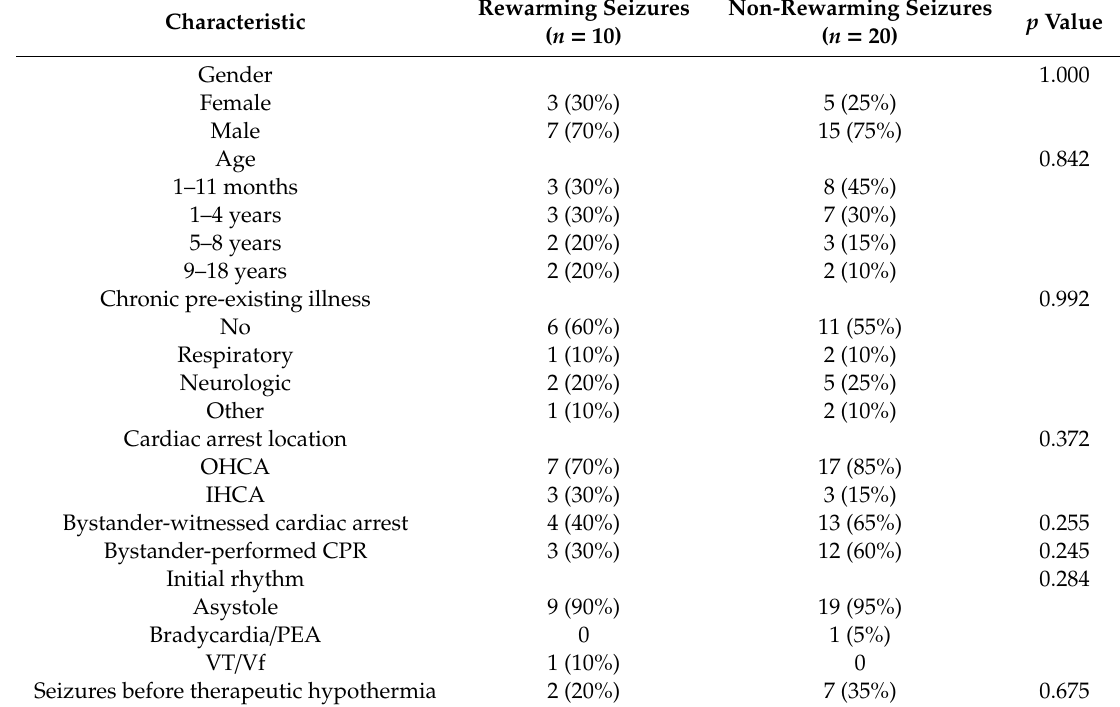
Table 1. The characteristics of 30 children undergoing therapeutic hypothermia after resuscitation.